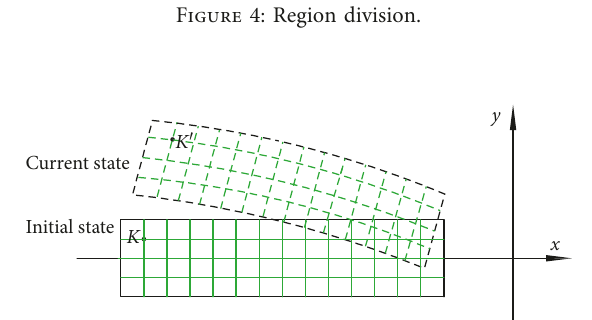
Figure 5: XY plane of region #1.